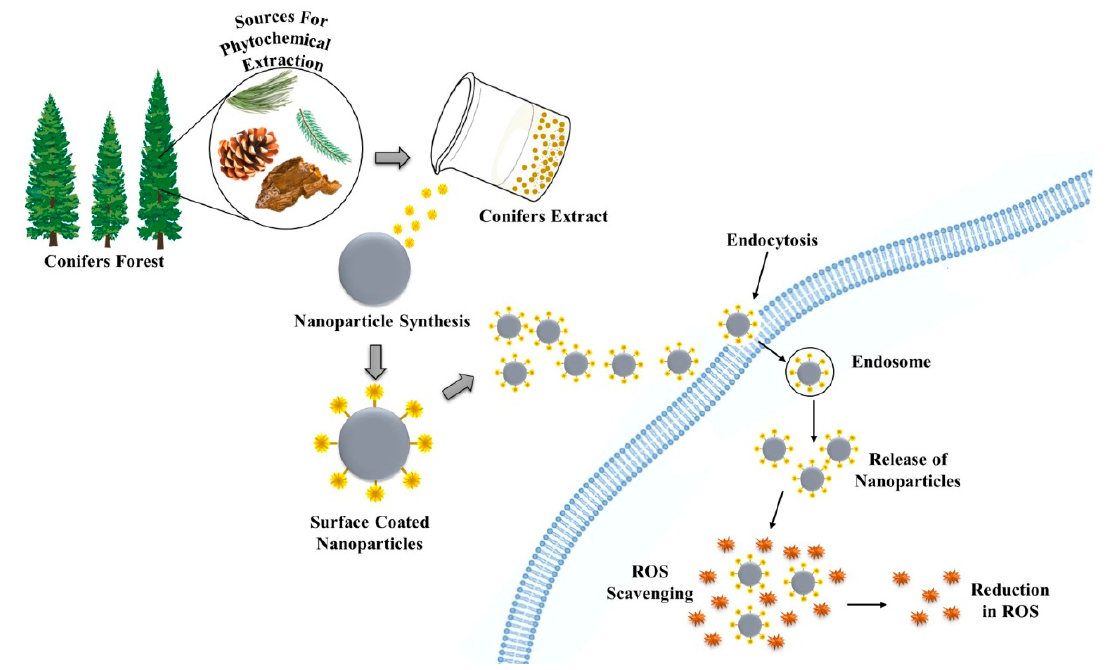
Figure 5. Graphical illustration of the antioxidant mechanism of nanoparticles.